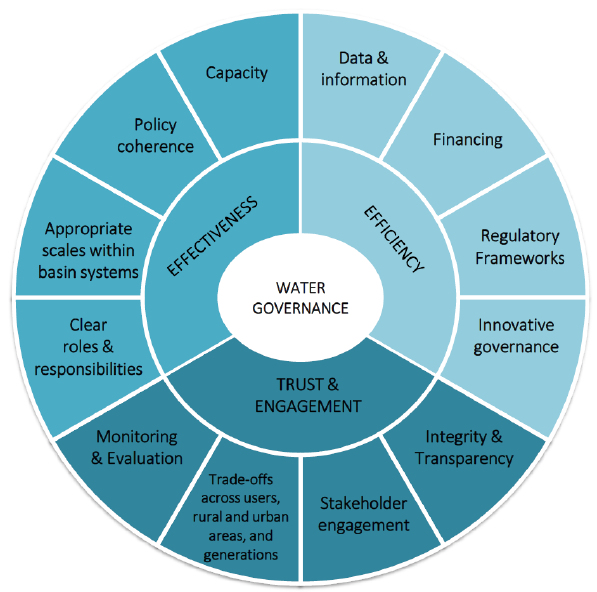
Figure 1. Organisation for Economic Co-operation and Development (OECD) Water Governance Principles [15].